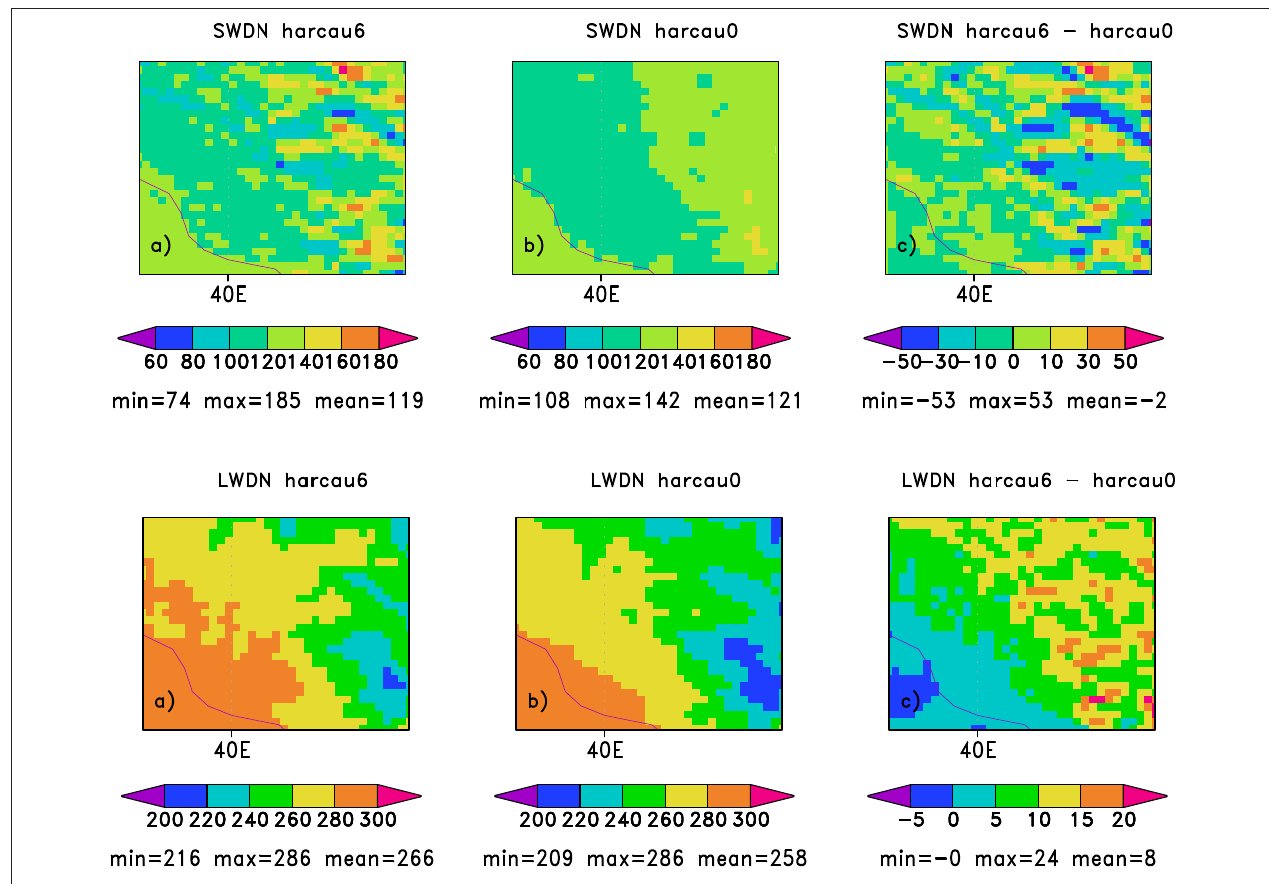
FIGURE 8 | Monthly average SWD (upper panel) and LWD (lower panel), unit: Wm − 2 , based on accumulated fluxes from 00 UTC + 24 h forecasts 1–28 February 2014 with and without ororad parameterizations: (A) harcau6, (B) harcau0, and (C) their difference, map zoomed to the Olympic venue area. Color scales are shown in the figures. See Table 2 for the experiment definitions and Figure 5 for the surface elevation contour map of the Olympic venue area.